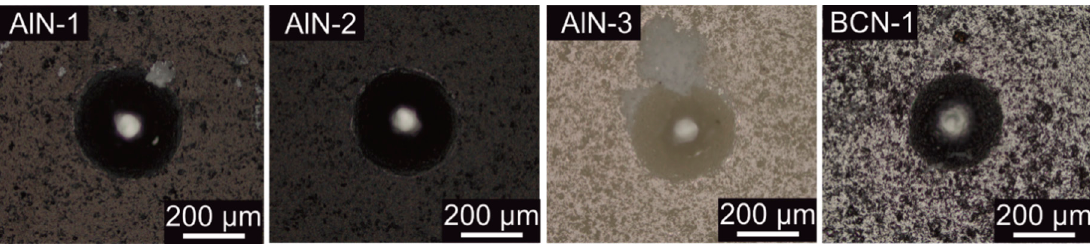
Figure 3. Light microscope images of the Rockwell indents of the AlN-1, AlN-2, AlN-3, and BCN thin films.